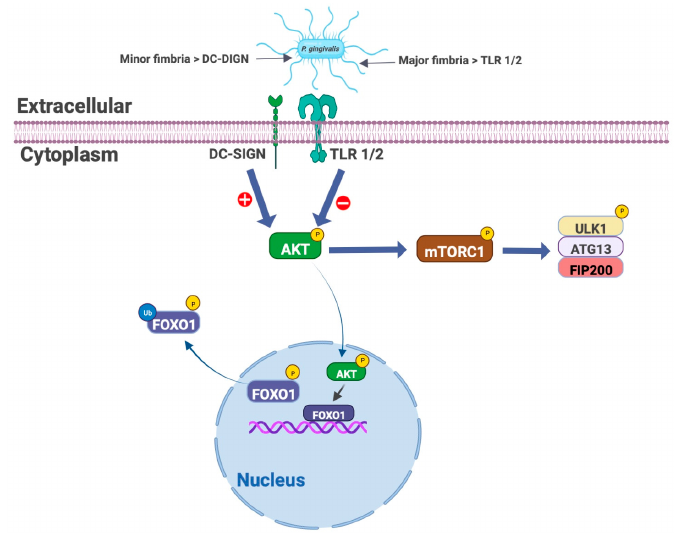
Figure 1. Manipulation of the AKT-FOXO1 pathway and AKT-mTORC1 pathway by P. gingivalis fimbriae.